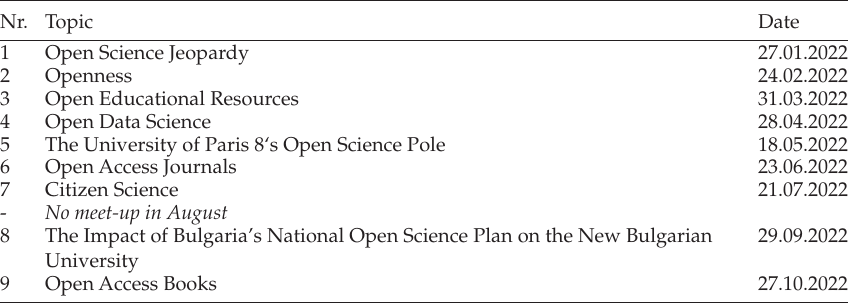
Table 1: List of the first eight ERUA Open Science Meet-Ups. Nr.